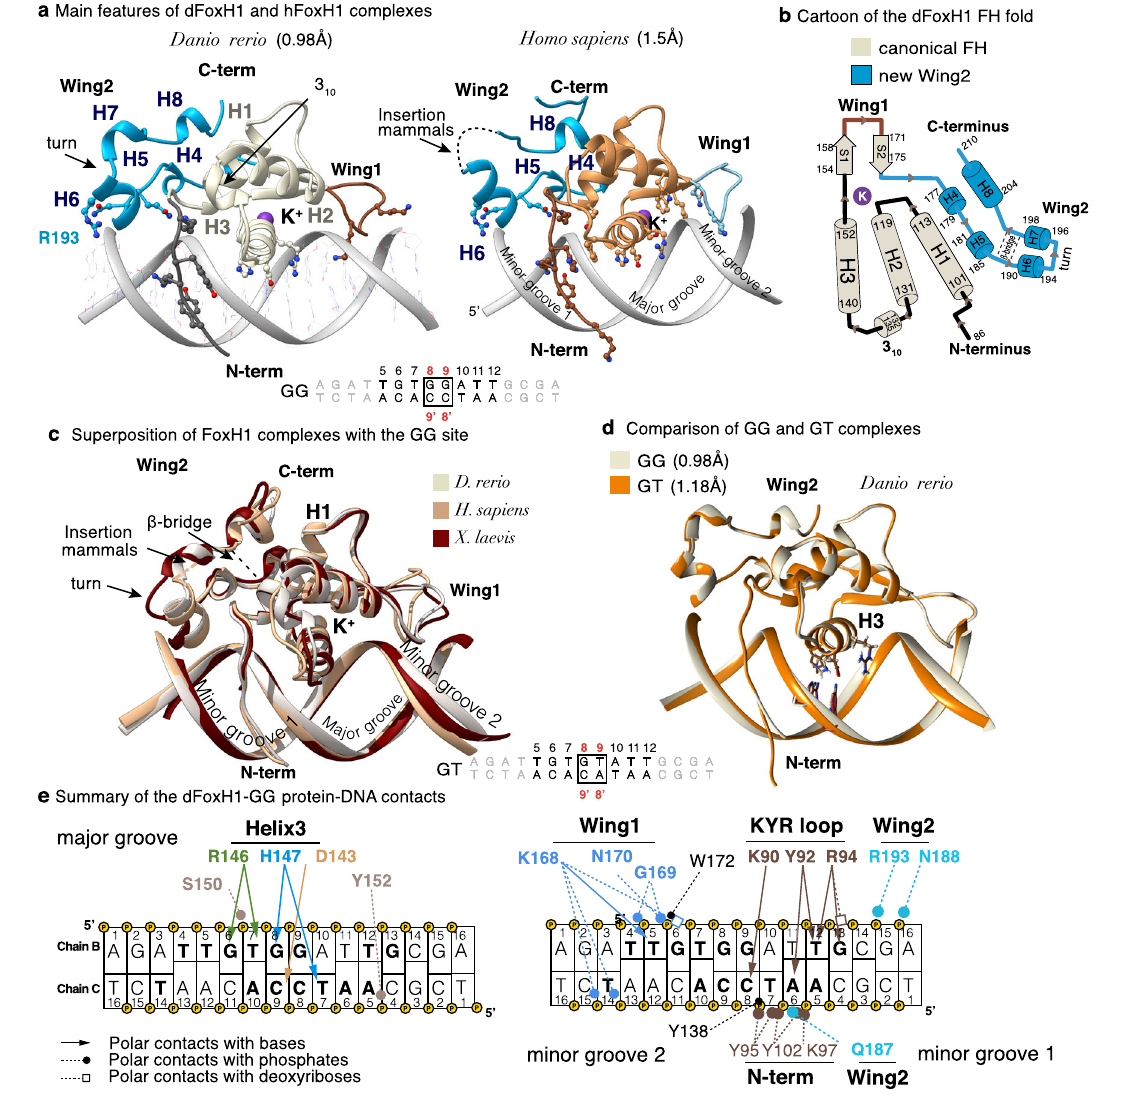
Fig. 2 | FoxH1-GK complexes structure. a Zebra fi sh and human FoxH1-GG com- plexes. The K + cation is displayed as a violet sphere. The GG sequence and the elements of secondary structure are indicated. Wing1 and 2 are colored in blue. b Schematic drawing of the secondary structure elements. The core domain is showninbeigeandthenovelWing2inblue. c Superpositionofthehuman,frogand zebra fi sh FoxH1-GG complexes. Regions with differences between structures are